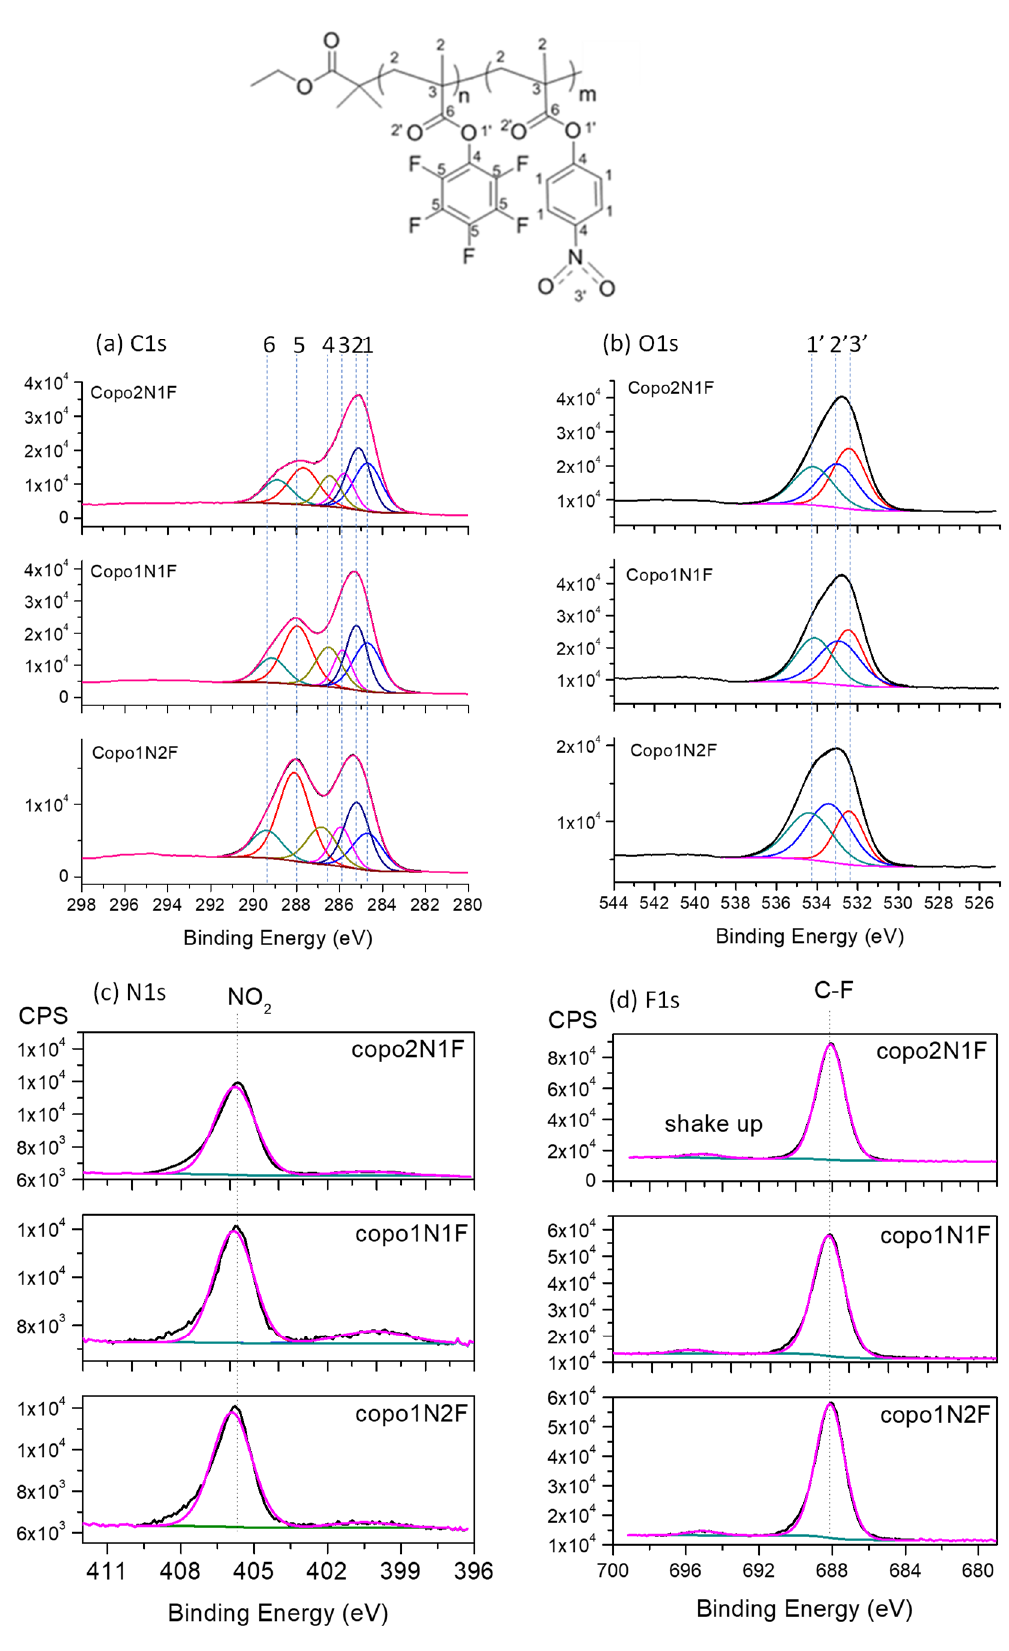
Figure 4. Deconvolution of ( a ) C1s, ( b ) O1s, ( c ) N1s, and ( d ) F1s core-level scans of copolymers at different compositions.